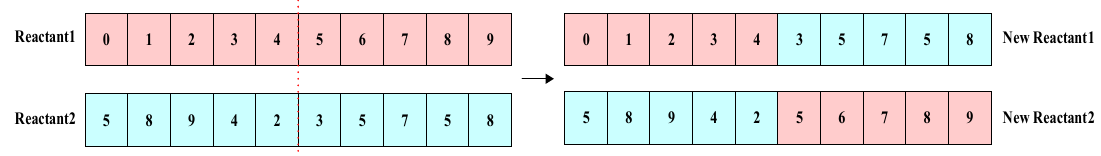
Figure 8. Displacement reaction operation representation.